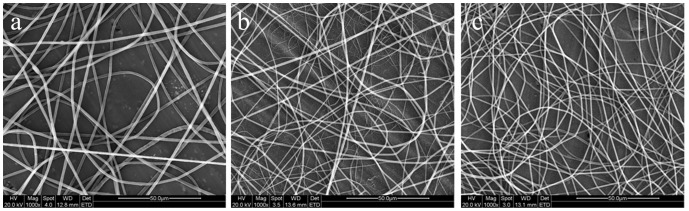
SEM micrographs of electrospun NFS in different weight ratios: (a) 3/1 PLLA/PCL, (b) 2/1 PLLA/PCL, and (c) 1/1 PLLA/PCL.Scale bar  = 50 μm. At the condition of mass flow rate of 1.0 ml/h, electrical field of 20 kV and syringe needle tip-to-collector distance of 15 cm, the PLLA/PCL blends of varied blending weight ratios were electrospun into fibers. The AD of fibers decreased with the increasing PCL content in the blends.